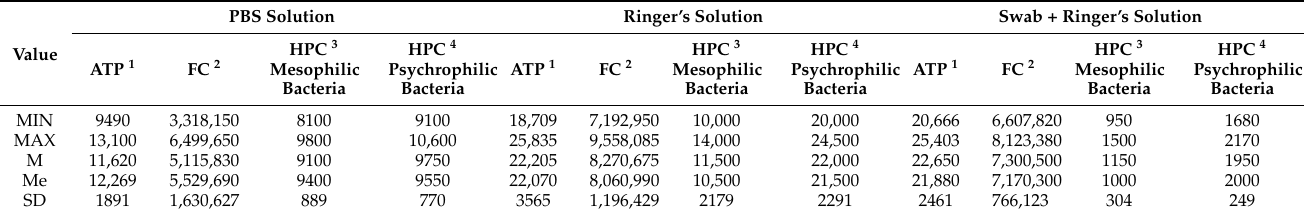
Table 2. Summary of the results of the quantitative analysis of the biofilm depending on the method of detachment used (n =